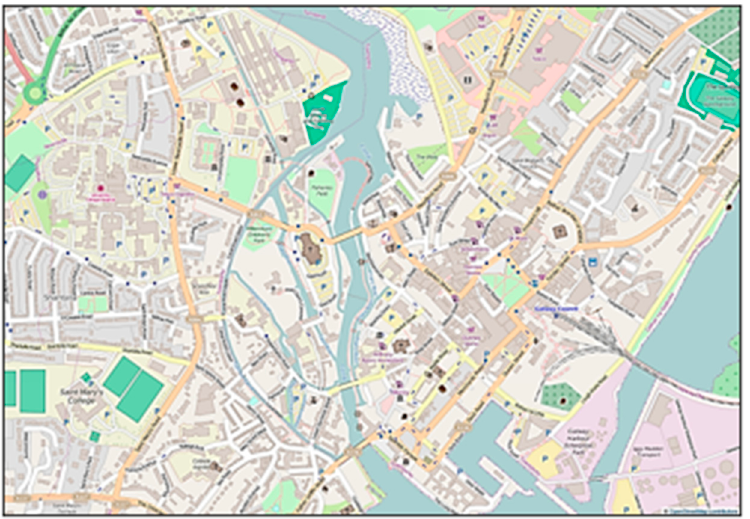
Figure 1. Example of a large map used during workshops with adolescents (© OpenStreetMap contributions).